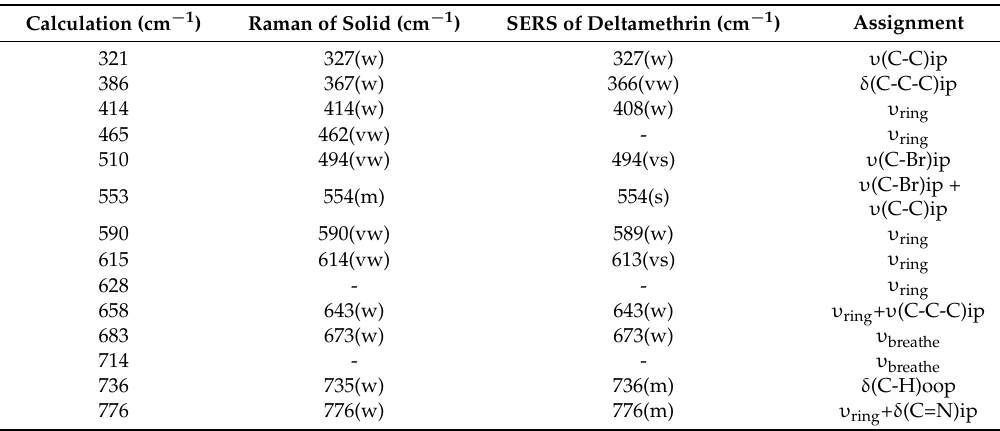
Figure 2. The RS of deltamethrin: ( a ) the theory calculation by density functional theory; ( b ) RS of deltamethrin solid; ( c ) SERS of deltamethrin solution. Table 1. The assignment of Raman peaks of deltamethrin